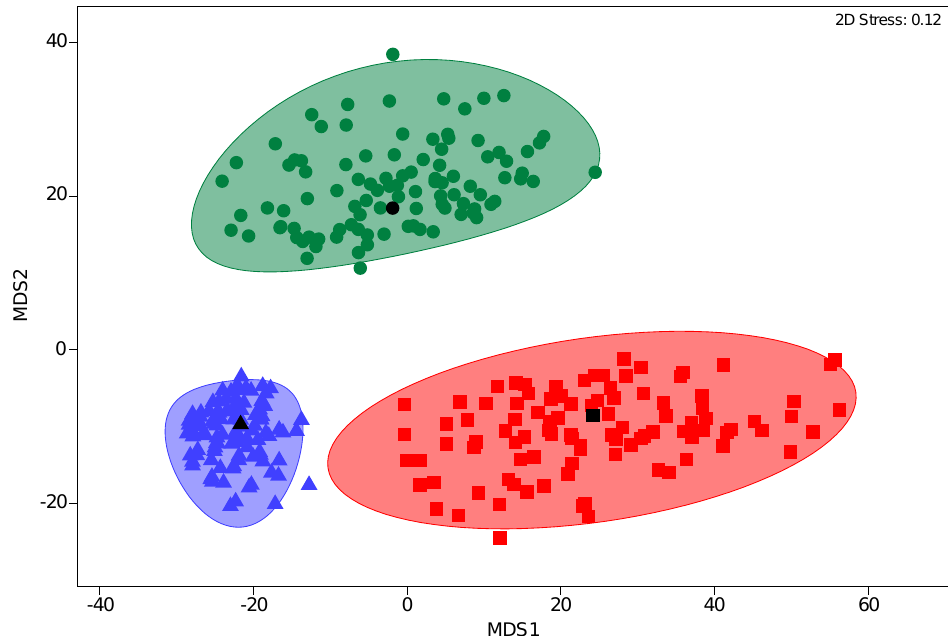
Figure 3. Metric multi-dimensional scaling ordination of ostracod samples with group averages (black symbols) and approximate 95% region estimates fitted to bootstrap averages (shaded areas) for three freshwater ecoregions: Okavango (triangles), Kalahari (squares), and Zambezian Lowveld (circles).